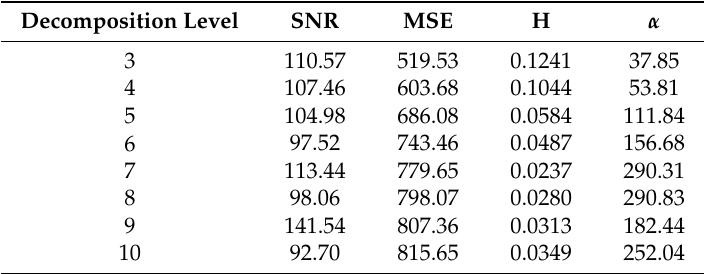
Table 3. Results of different decomposition levels with coif 3. Table 3 . Results of different decomposition levels with coif 3.